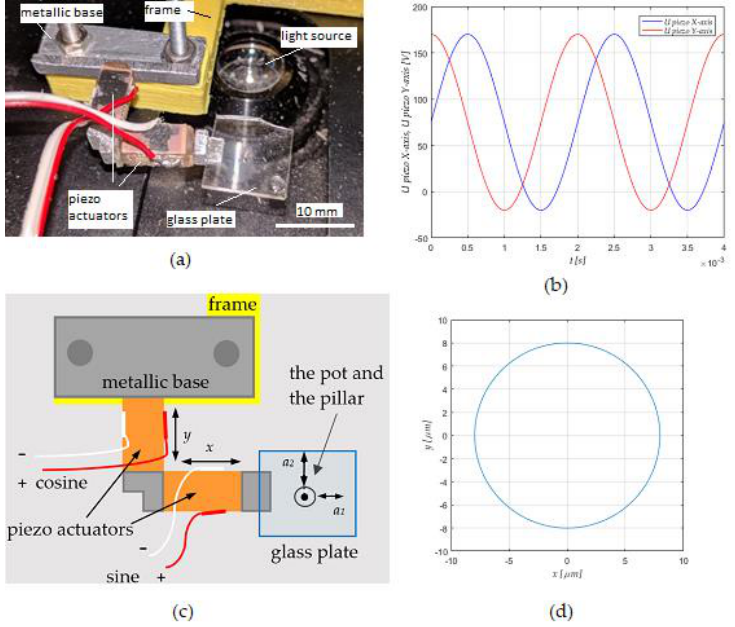
Figure 1. ( a ) Mechanical part of the lab set-up with two perpendicularly attached piezo actuators, ( b ) cosine and sine sinusoidal voltage supply voltage V pp for the piezo actuators, ( c ) the scheme of the mechanical part, and ( d ) circular vibrational movement.